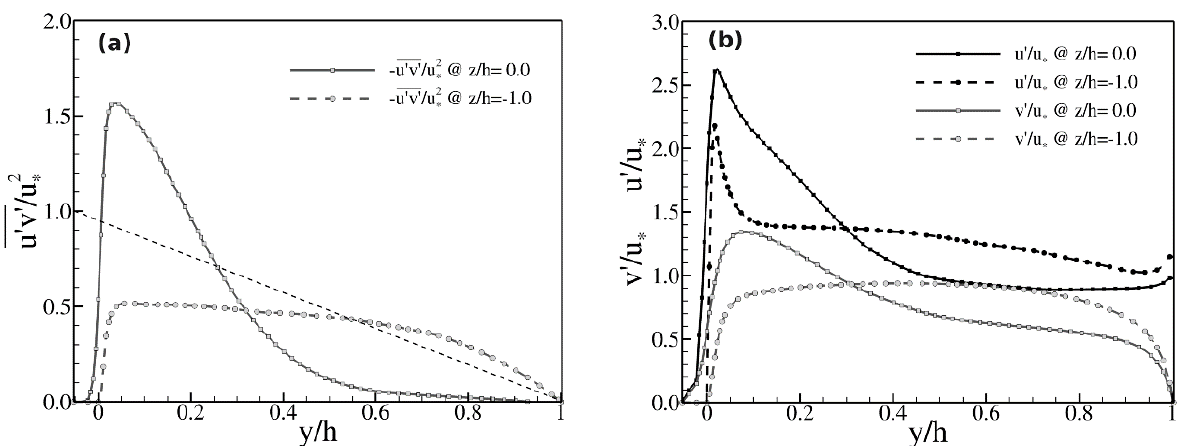
Figure 8. Profiles of the primary shear stress ( a ) and streamwise and wall normal turbulence intensities ( b ) over smooth ( z / h = − 1.0) and rough ( z / h = 0.0) strips. In both plots the global shear velocity has been used for